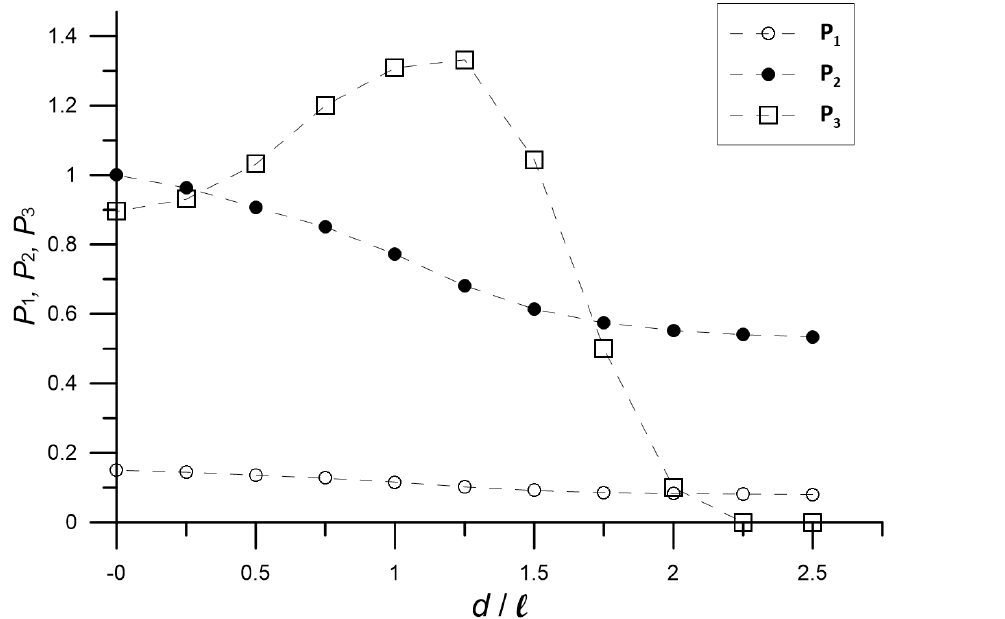
Figure 5. Trend of the inversion effectiveness parameters P 1 , P 2 and P 3 , referring to the cube-shaped model shown in Figure 1, as the ratio d / l between the orthogonal distance d and the side of the cube l